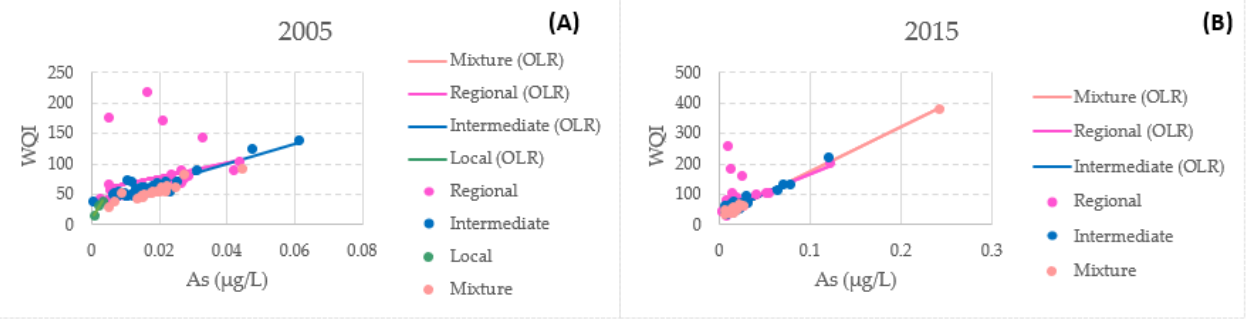
Figure 14. Uncertainty weighted least-squares linear regression (arsenic and WQI) for the different flow systems: ( A ) 2005 and ( B ) 2015.